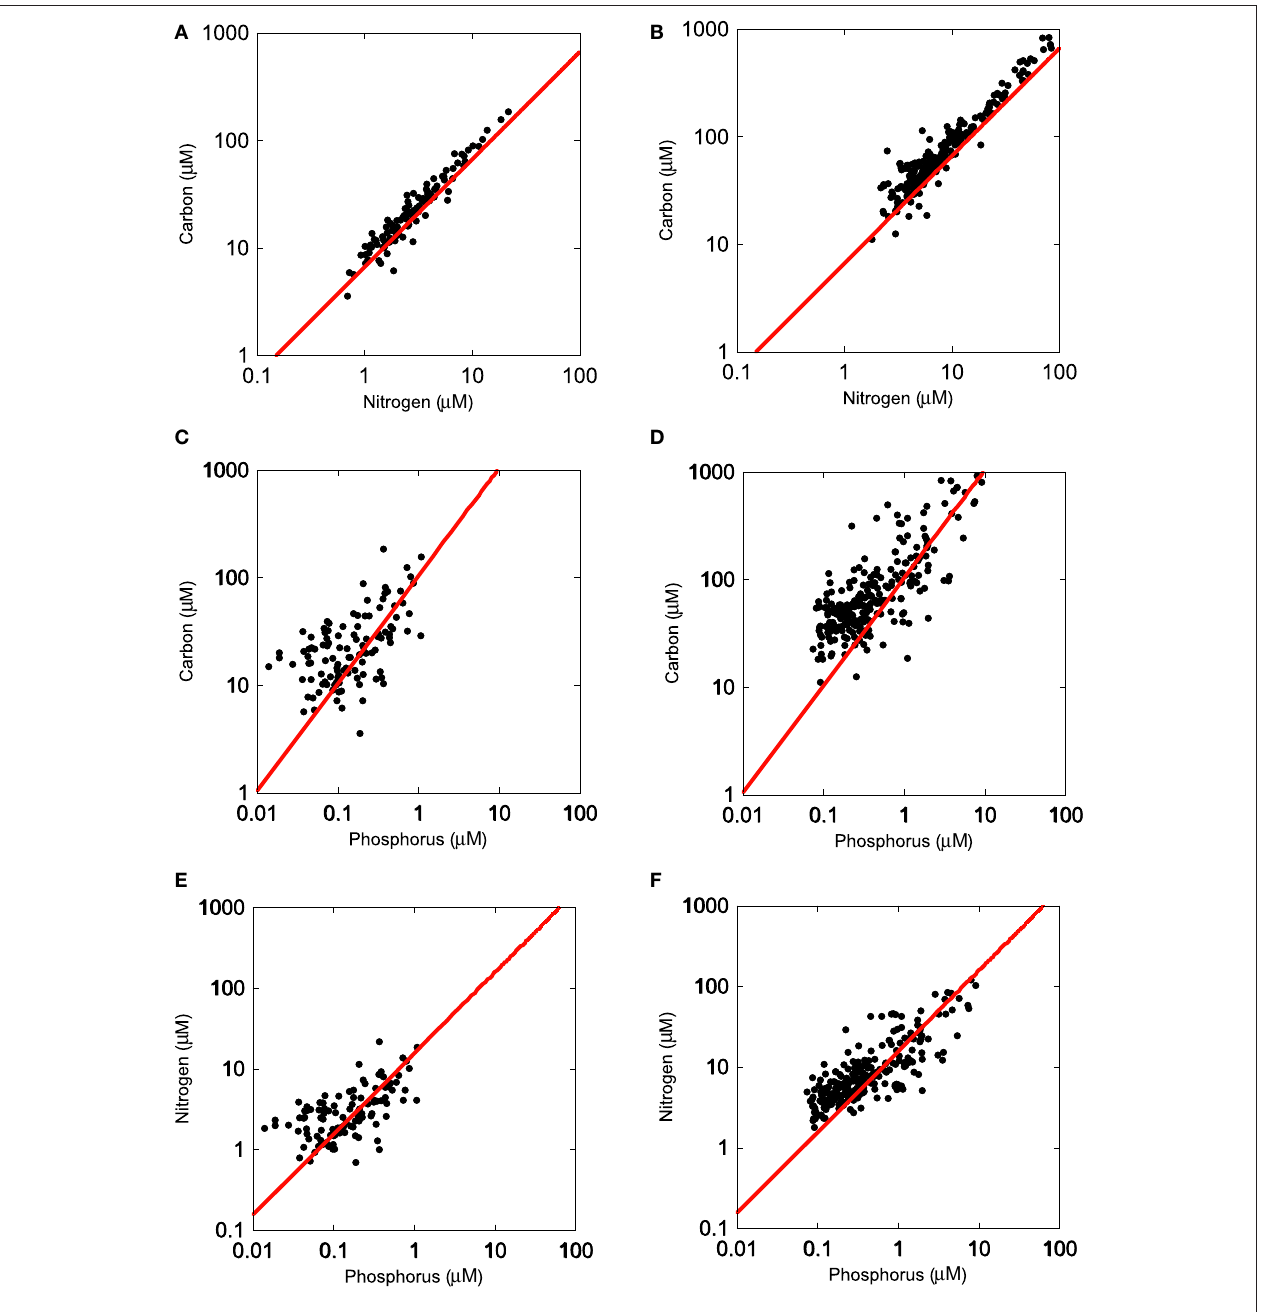
Figure 1 | regressions (SMA) of organic carbon, nitrogen, and phosphorus content in the < 1 m m size-fraction [left panels (A,C,e)] and < 80 m m seston [(right panels (B,D,F)]. Samples were collected in > 120 lakes in the Upper Midwest (MN, IA, SD, MI). The red line represents the Redfield ratio of these